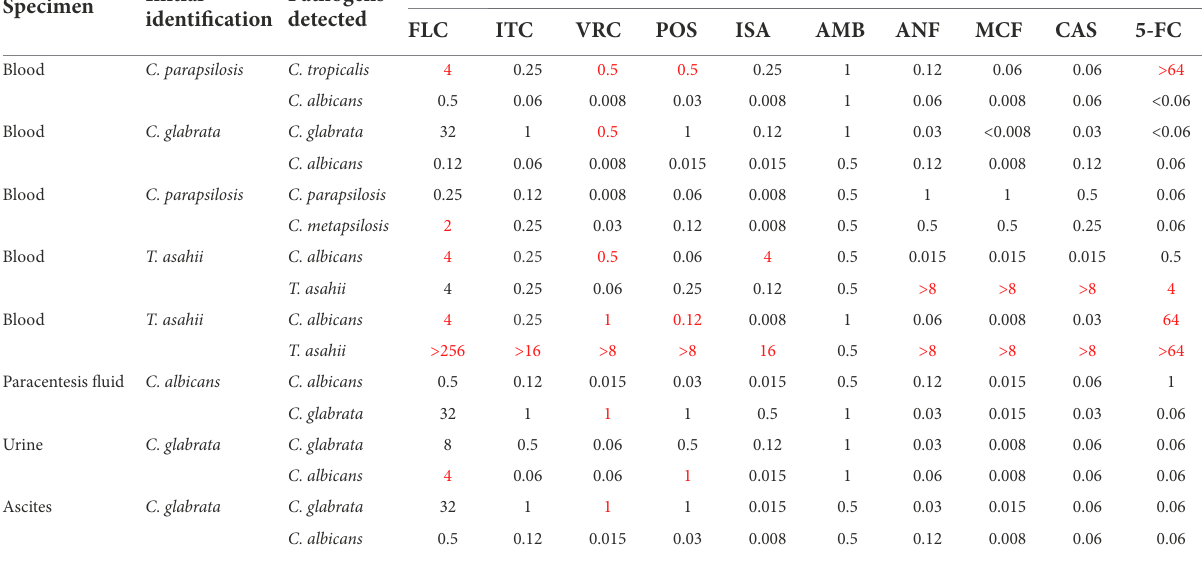
TABLE 1 Distribution of co-isolated yeast species in specimens and their antifungal susceptibility profiles.